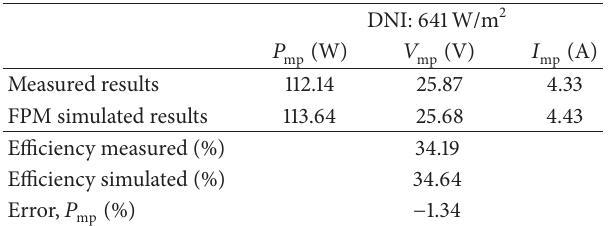
Figure 15: I-V curve of measured data (red line with dots) acquired during field test is superimposed on FPM simulation curve (black line) and Matlab simulation curve (blue dashed line).